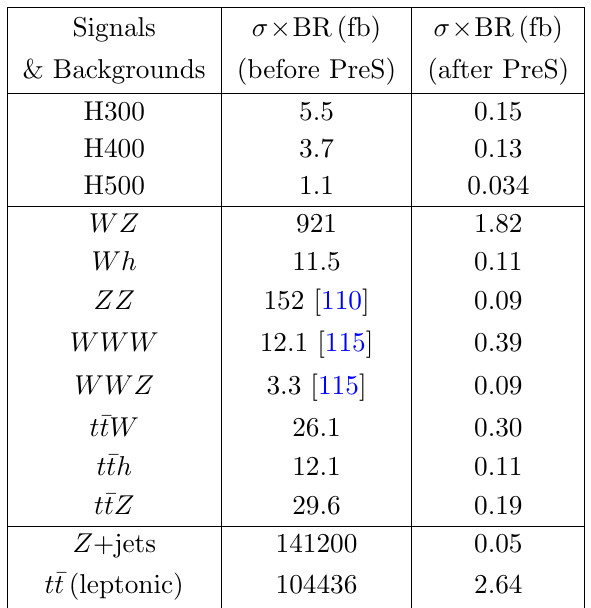
Table 6 . (cid:27) (cid:2) Br for the signal process (with three benchmarks) and the major backgrounds in the 3L decay channel before and after the pre-selections (PreS), where the last category denotes backgrounds with fake